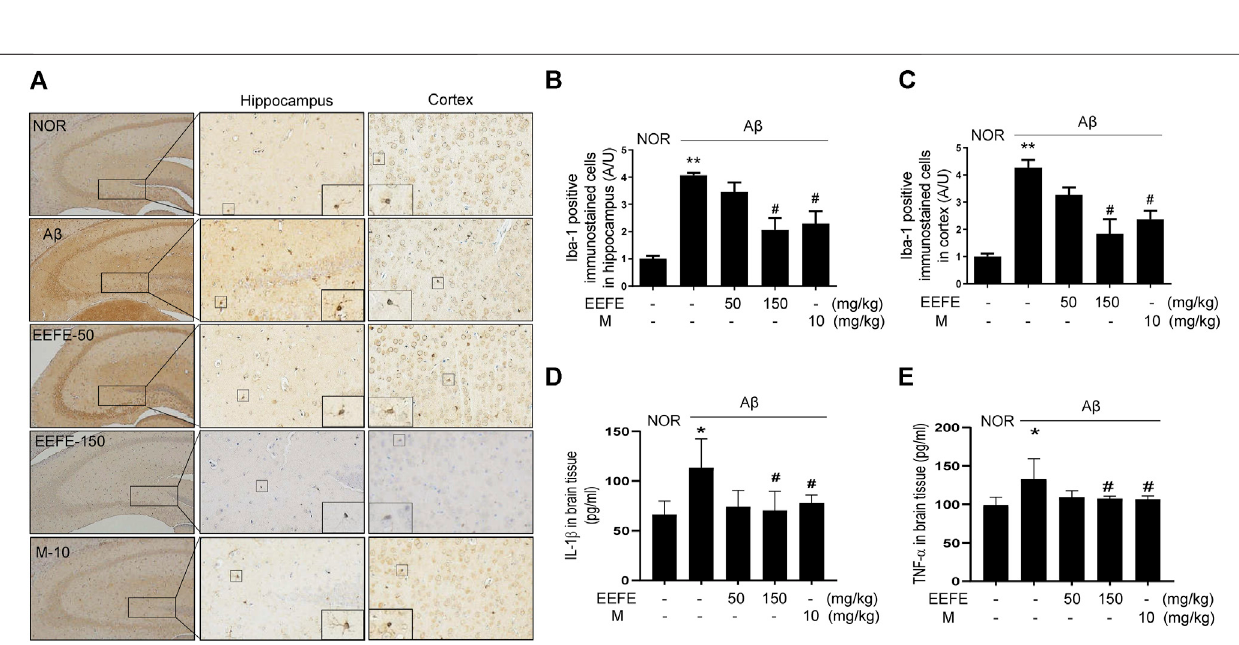
Frontiers in Pharmacology |